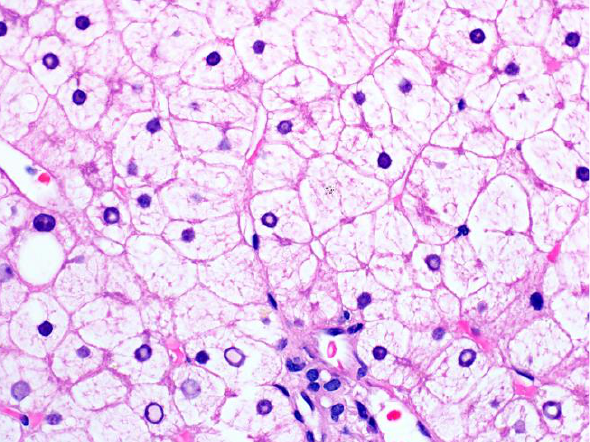
Figure 3. A liver biopsy from a patient with glycogenic hepatopathy demonstrating swollen hepatocytes with abundant clear cytoplasm due to glycogen accumulation (H&E stain; original magnification 600×). Occasional glycogenated nuclei can be seen.